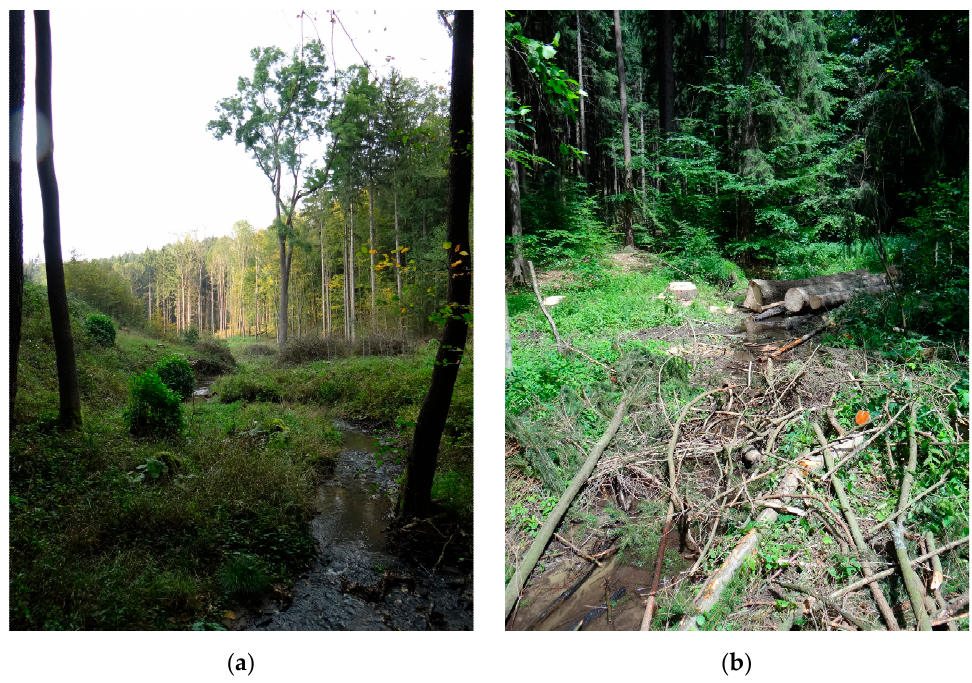
Figure 8. Harvesting of forest stands in habitats of C. heros : ( a ) clear cut on the banks of stream; ( b ) individual harvesting in the habitat and also in the stream.